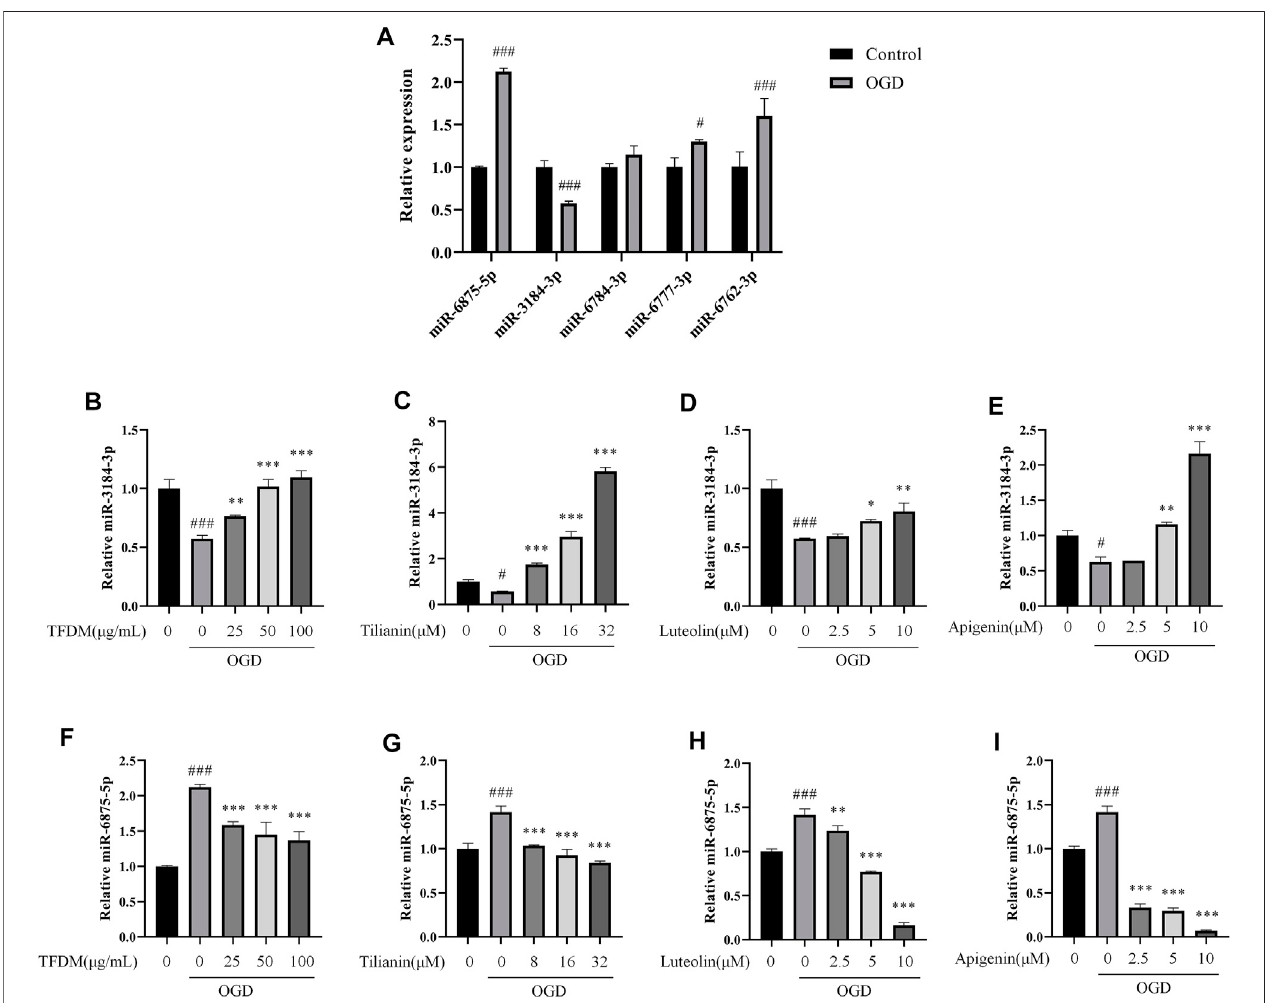
FIGURE 10 | Regulation of miR-3184-3p and miR-6875-5p by TFDM and active compounds in OGD-injured SH-SY5Y cells. (A) Changes in the expression of miRNAs in OGD-injured SH-SY5Y cells compared with control cells. (B – E) Upregulation of miR-3184-3p in OGD-injured SH-SY5Y cells after the treatment with TFDM (B) and the active compounds tilianin (C) , luteolin (D) , and apigenin (E) . (F – I) Downregulation of miR-6875-5p in OGD-injured SH-SY5Y cells after the treatment with TFDM (F) andtheactivecompoundstilianin (G) ,luteolin (H) ,andapigenin (I) .StatisticalanalysiswasperformedusingStudent ’ s t -testorone-wayANOVAfollowed by a Tukey ’ s multiple comparison test. n (cid:2) 3. ### p < 0.001 vs . control; * p < 0.05, ** p < 0.01, *** p < 0.001 vs . OGD. Results were expressed as mean ± SD.